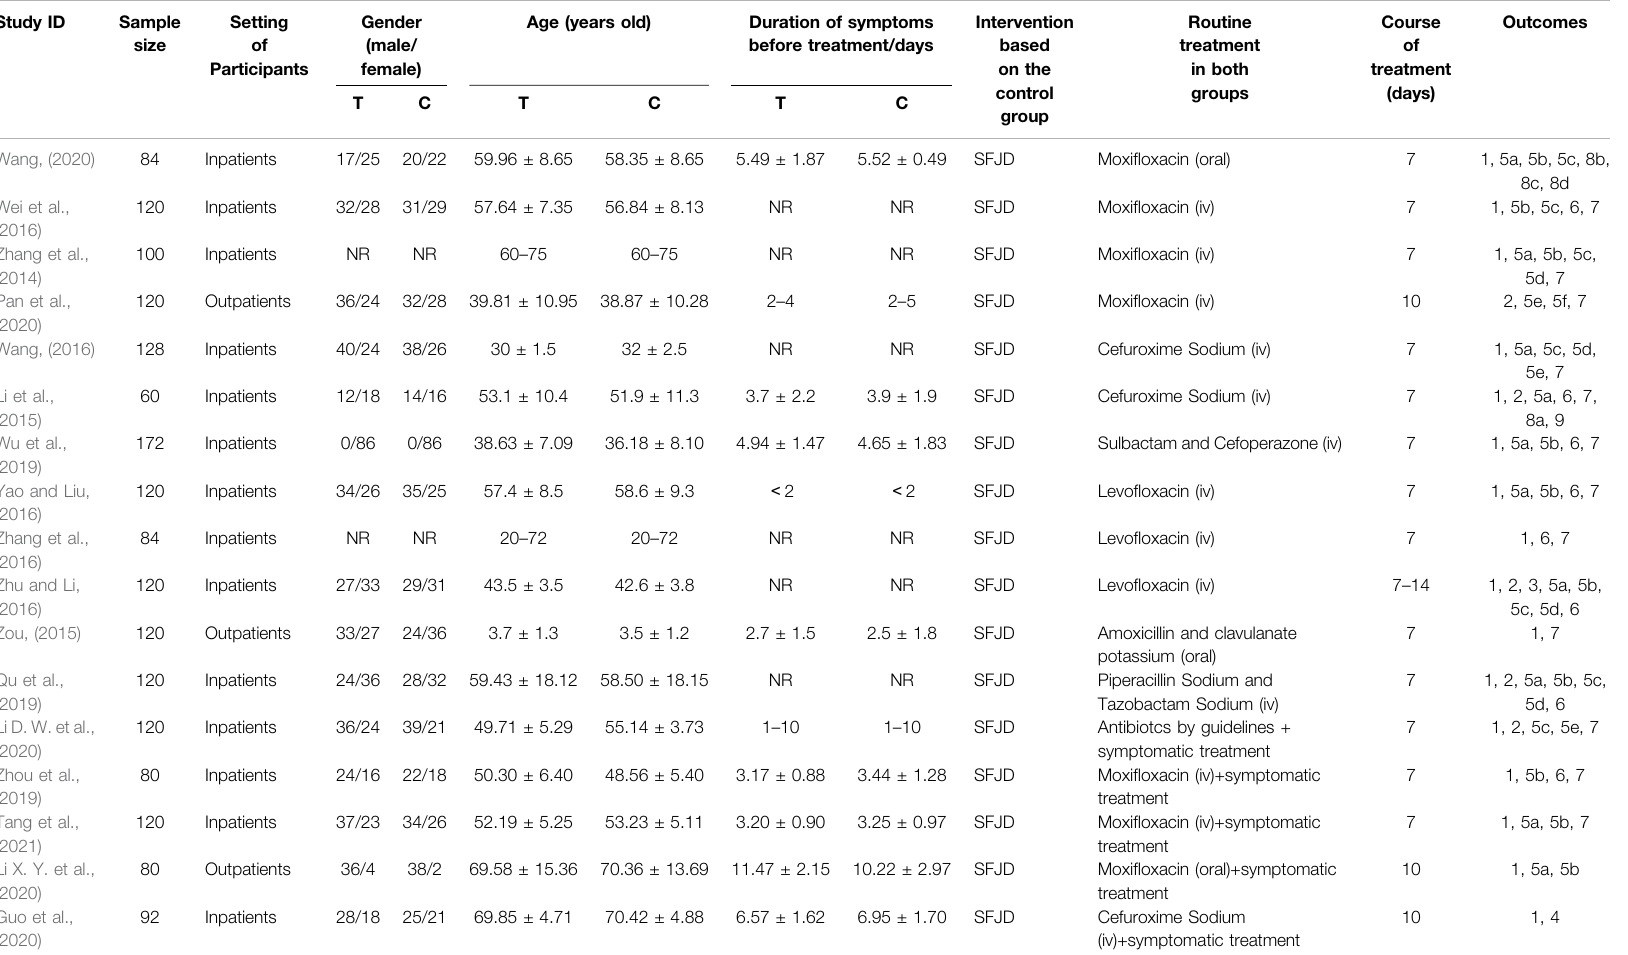
TABLE 1 | Characteristics of included randomized controlled